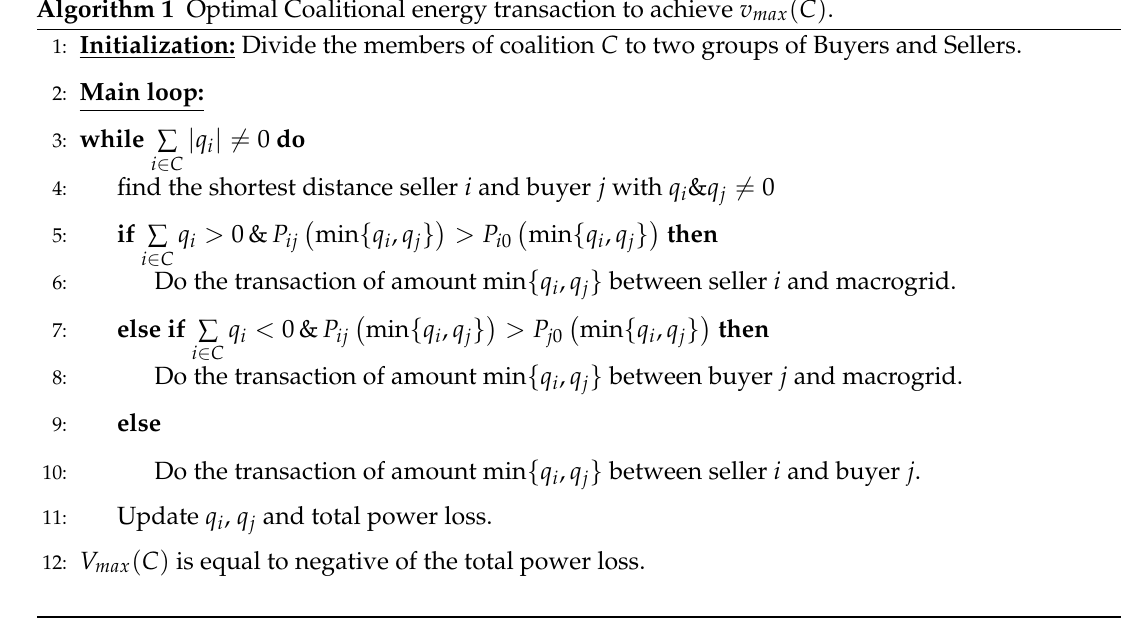
Algorithm 1 Optimal Coalitional energy transaction to achieve v max ( C )